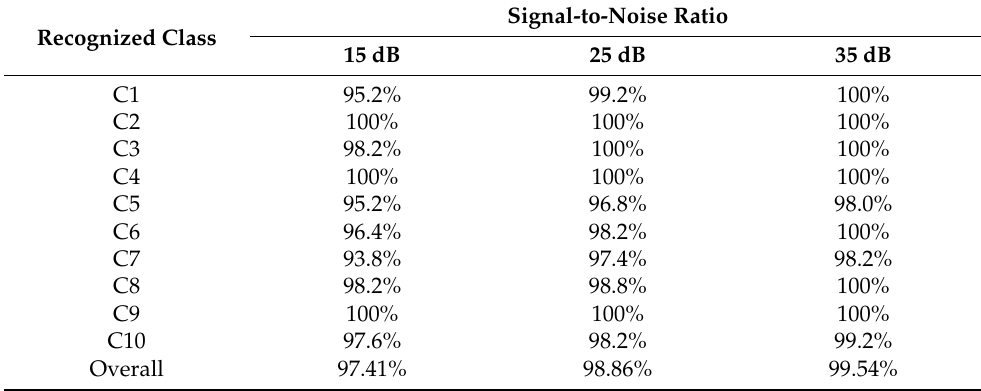
Table 4. Classification accuracy performance in a noisy